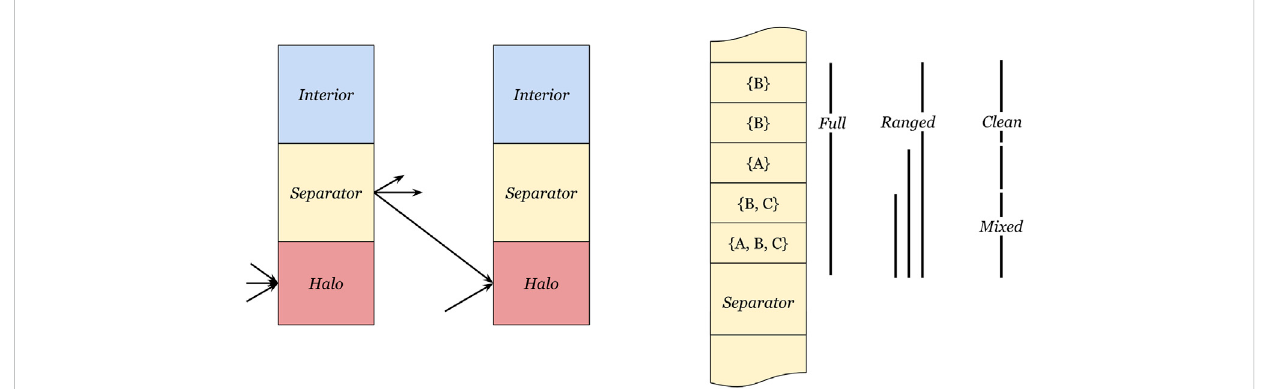
FIGURE 2 De fi nition of interior, separator, and halo cells. The left side depicts the three cell regions, where the interior region is not communicated, values in the separator region need to be sent to other partitions, and the halo region receives separator values from neighbor partitions. The right side depicts three separator range methods, (full) transmits the entire separator cell range to every neighbor, (ranged) uses the smallest enclosing range for each receiving partition, and (mixed-clean) splits the separator cell range into a mixed part and a clean